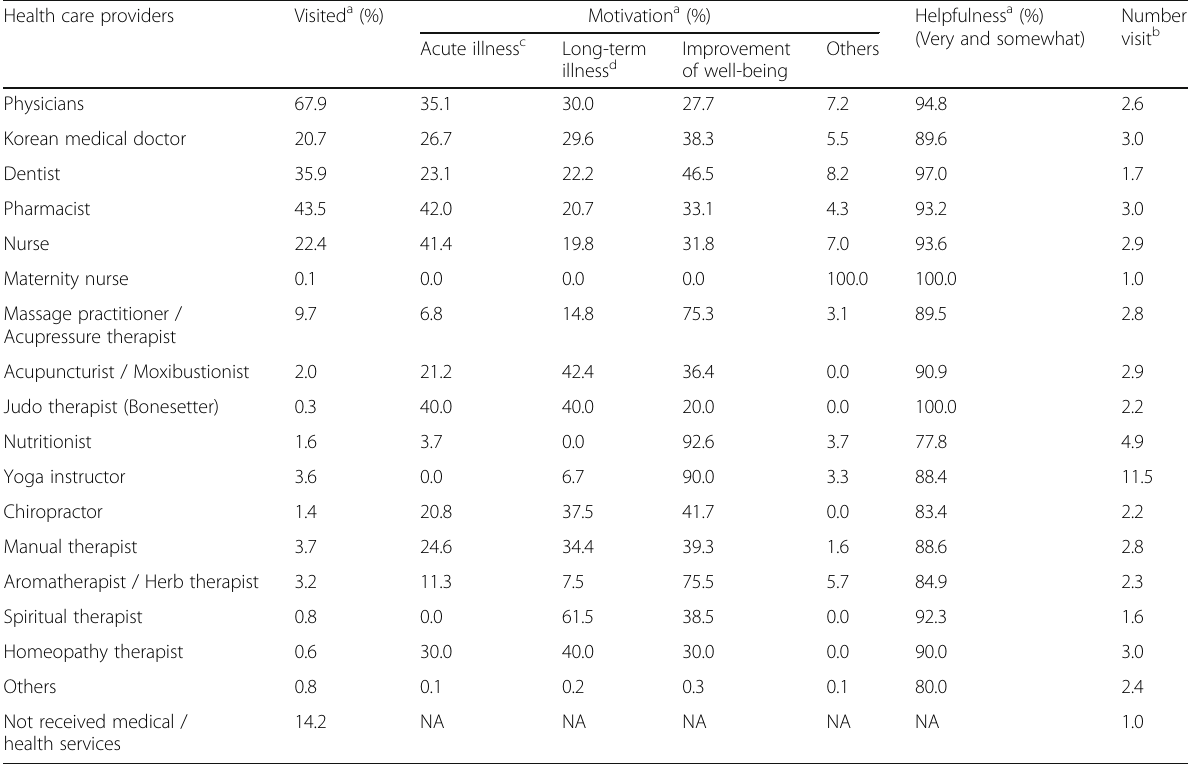
Table 2 Visiting health care